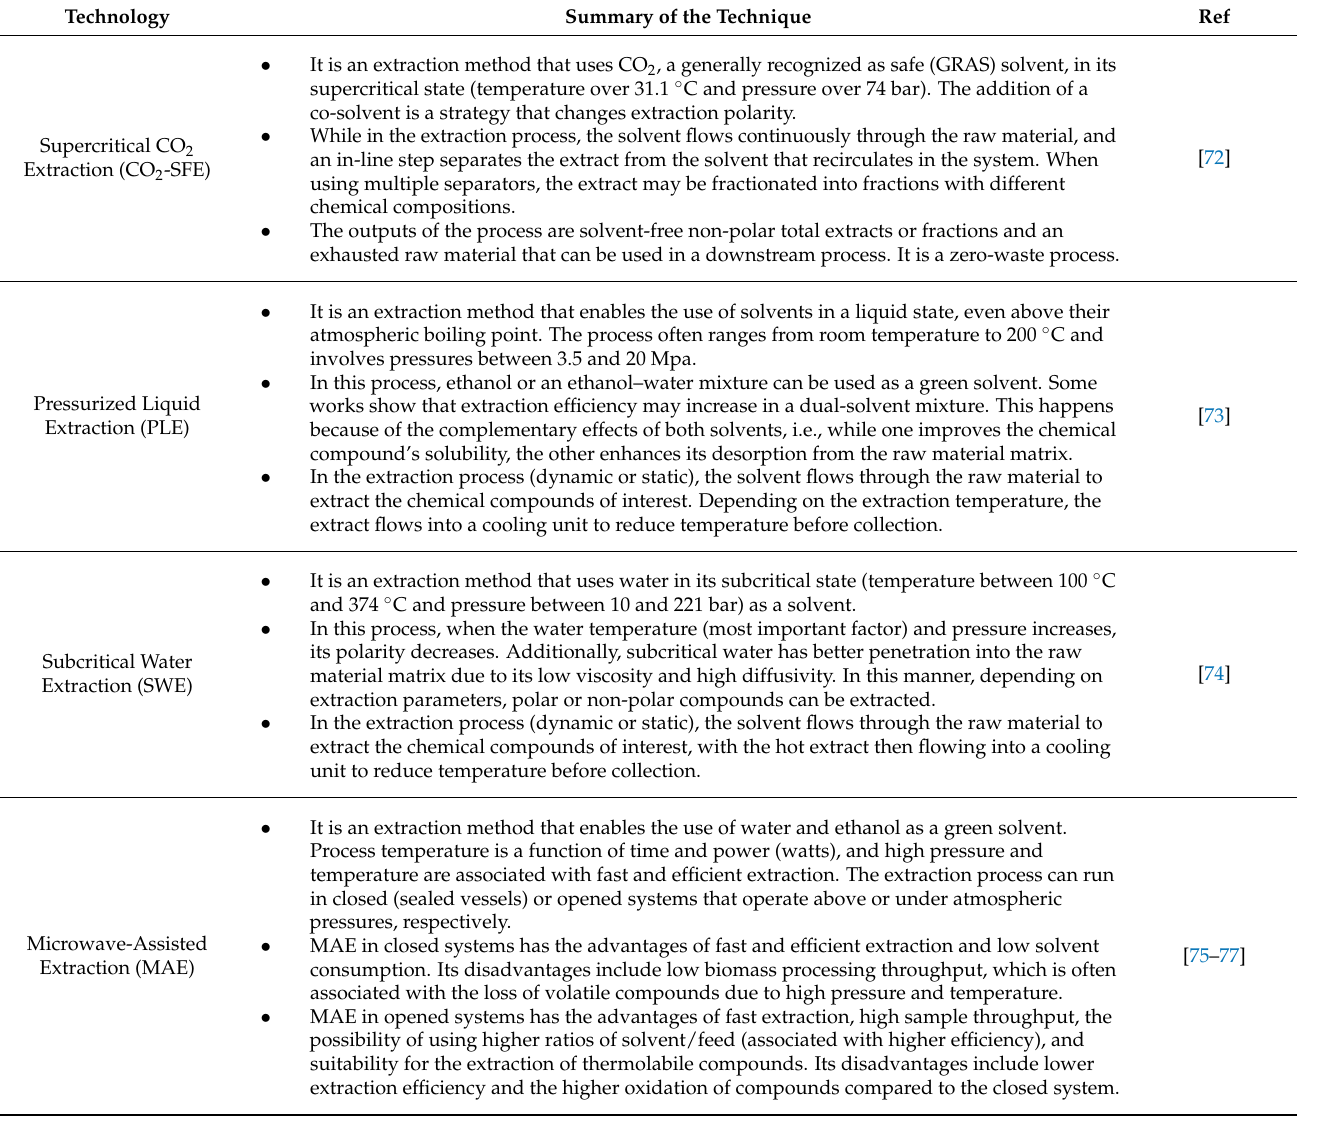
Table 4. Brief description of green extraction